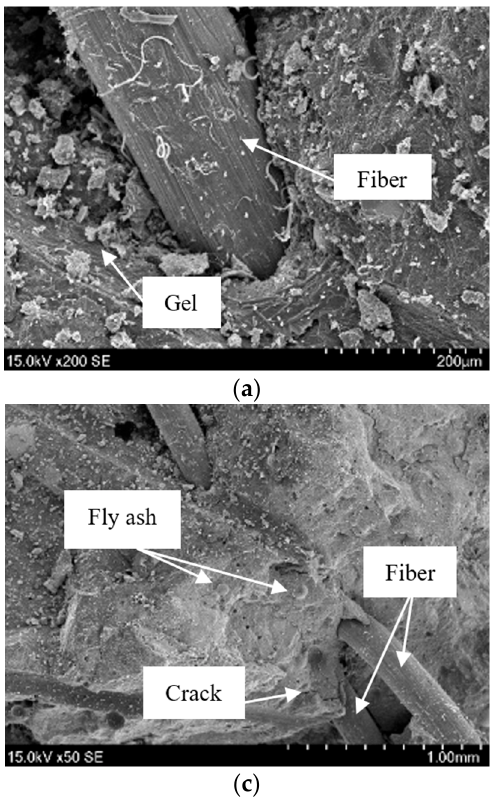
Figure 13. SEM micrograph of the connection between POM fiber and GRC matrix: ( a ) Single 6 mm POM fiber; ( b ) Single 12 mm POM fiber; ( c ) Multiple 6 mm POM fibers; ( d ) Multiple 12 mm POM fibers.